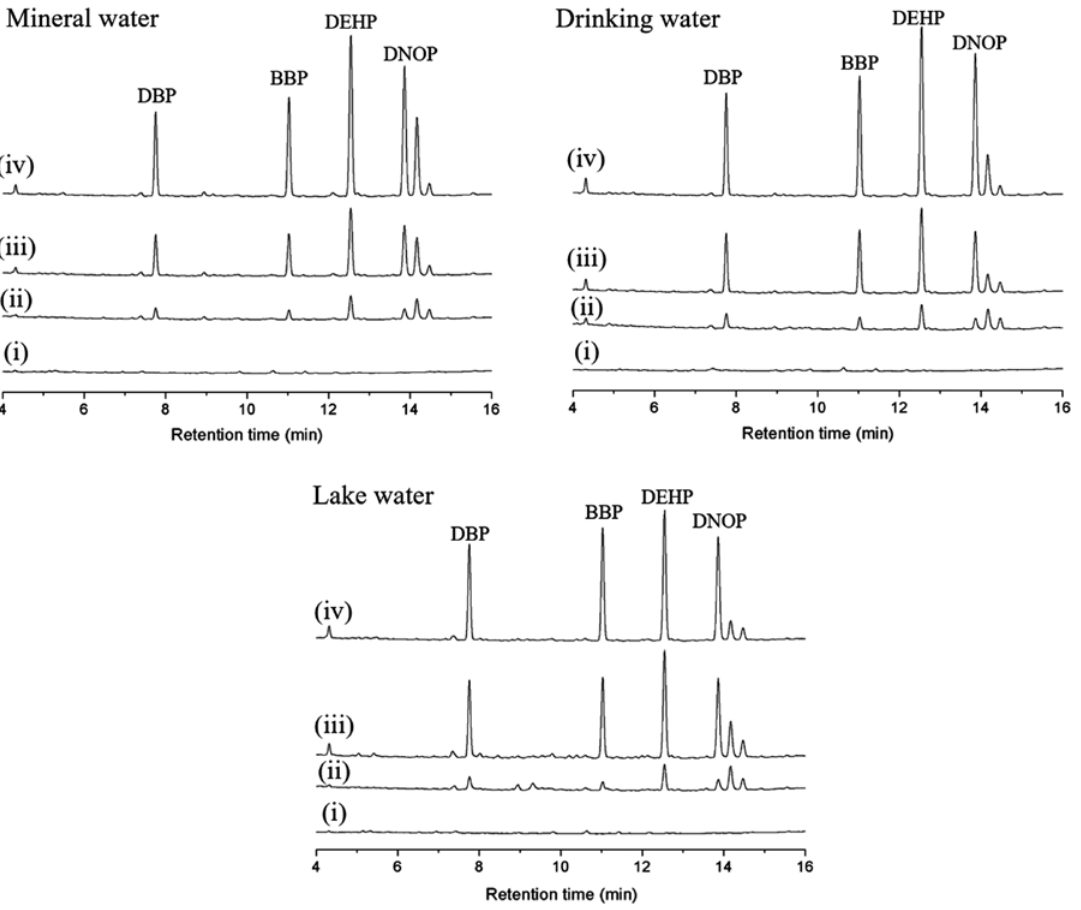
Figure 8: The GC-FID chromatograms of the PEs analysis in selected water samples with PEs spiked levels of (i) 0 μ g/l, (ii) 10 μ g/l, (iii) 50 μ g/l and (iv) 100 μ g/l.